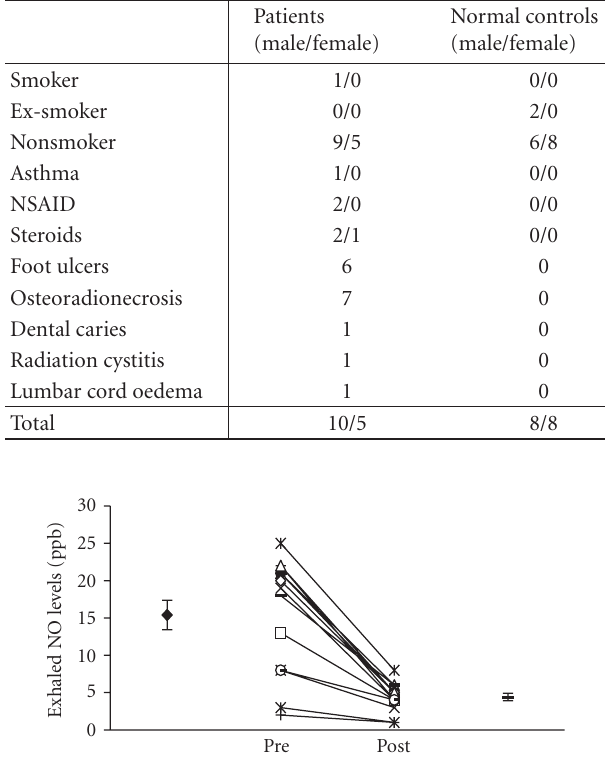
Figure 1: Exhaled nitric oxide levels in 15 patients undergoing HBOT immediately before and after treatment. There was a sig- nificant fall in these patients (mean ± SE, before 15 . 4 ± 2 . 0 ppb, afterwards 4 . 4 ± 0 . 5 ppb, P < . 001).